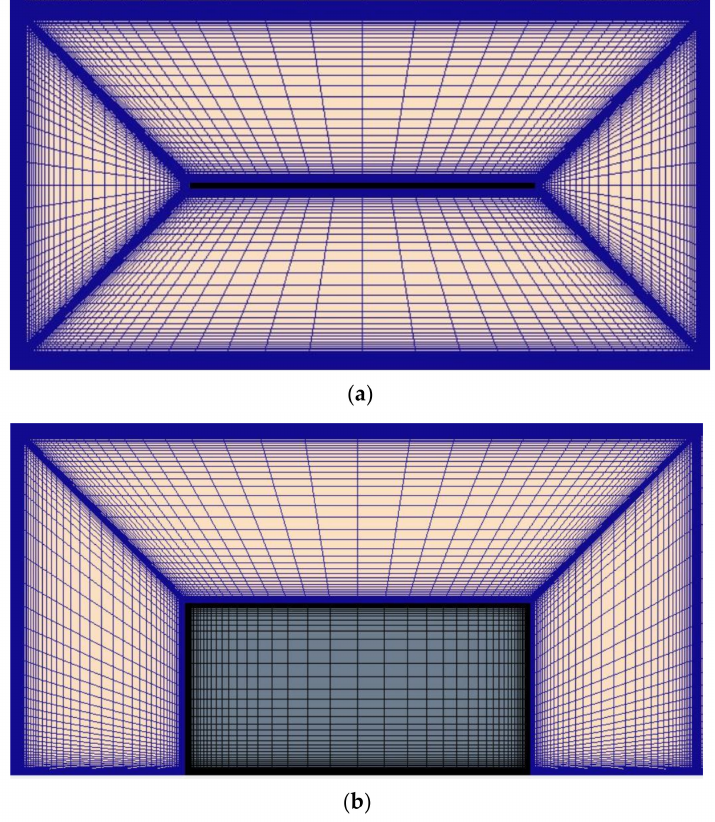
Figure 2. Refined mesh around the VG for H = 1 δ . ( a ) Top view and ( b ) side